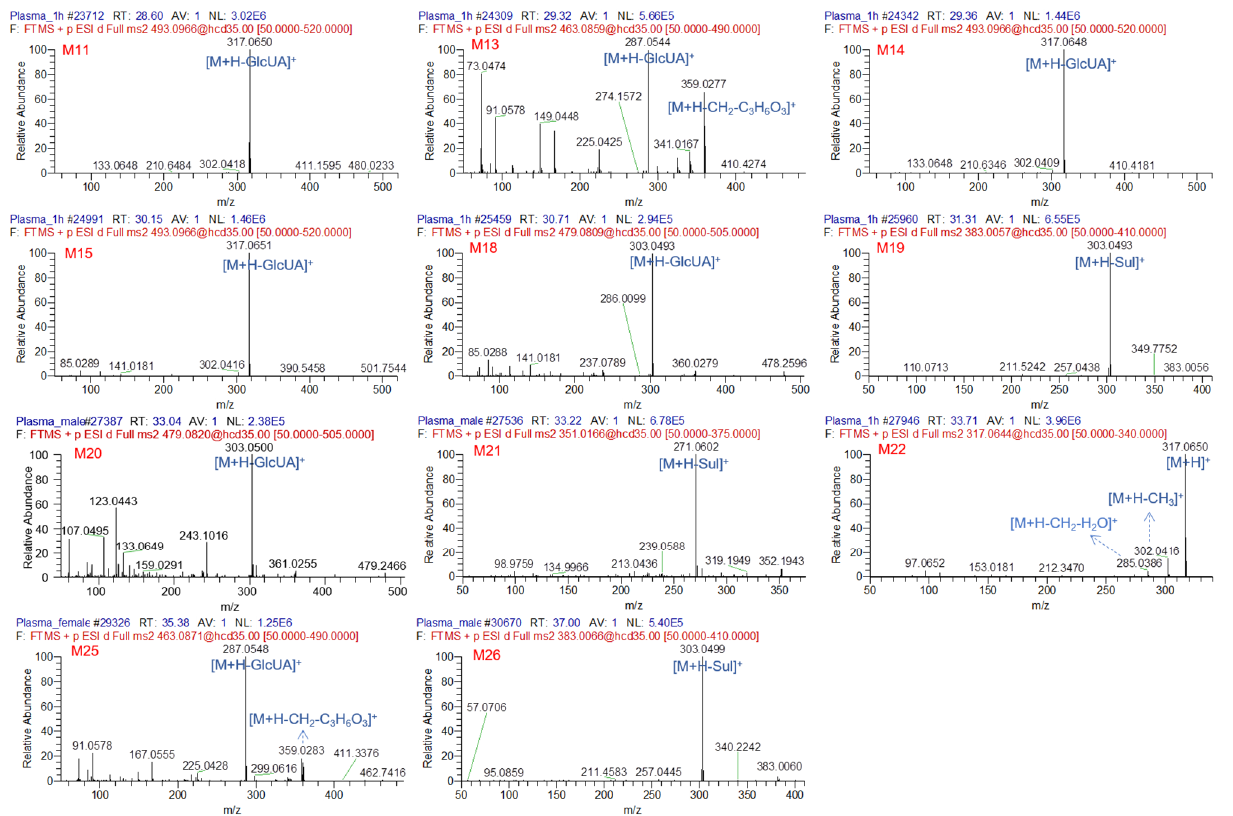
Figure 4. The MS 2 spectra of metabolites detected in rat plasma after oral co-administration of Tartary buckwheat extracts with ethanol.